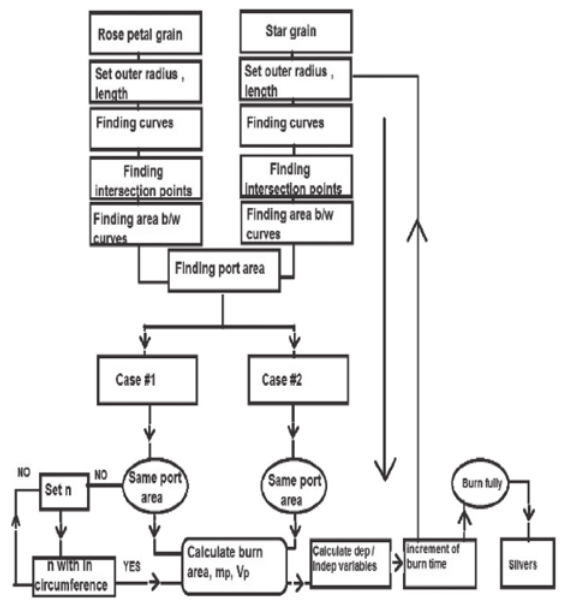
Fig. 1. Grain geometry and computational analysis module